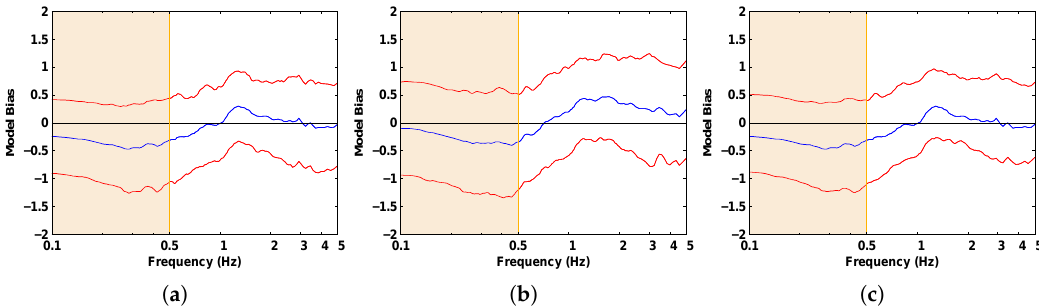
Figure 19. Bias in the synthetic 5%-damped acceleration response spectra at 46 stations relative to the corresponding spectra of recorded ground motion during the 2004 Parkfield earthquake. Blue line: Bias. Red line: Standard error. ( a ) North component, ( b ) East component, and ( c ) Geometric mean horizontal